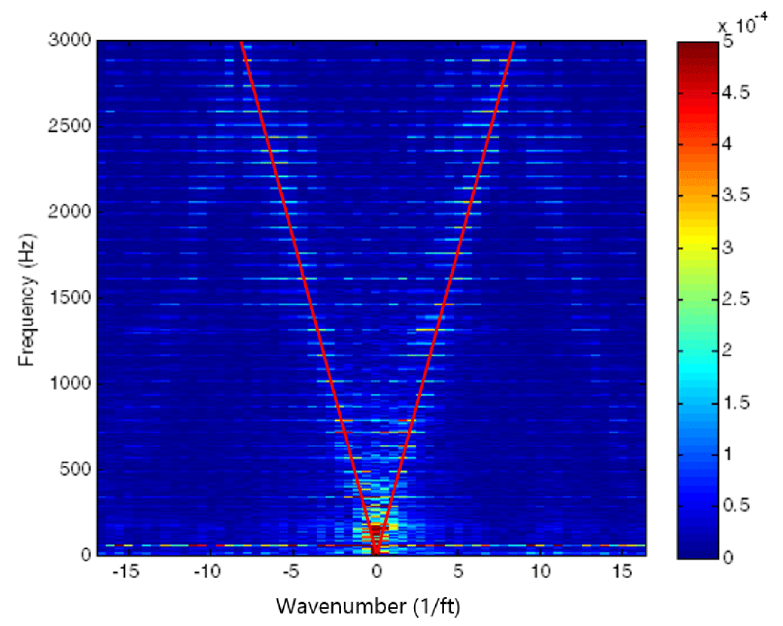
Figure 6. F-K plot generated using 2D-FFT with V-shape line fitting. Reprinted from ref